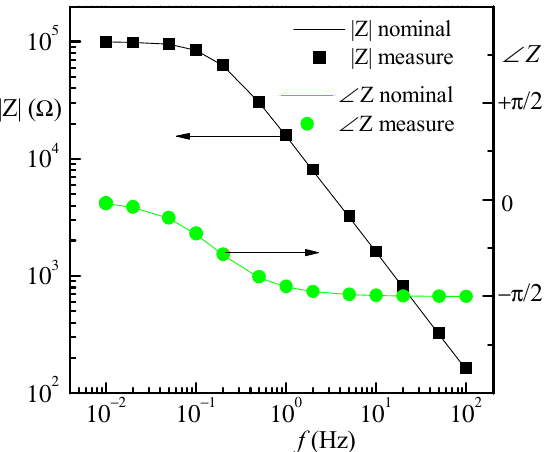
Figure 8. Result of test measurements on the impedance in Figure 6a. DC bias across the DUT was set to 0 and the AC amplitude of the test voltage was 10 mV at all frequencies. Quite good agreement is obtained between measurements (symbols) and the expected values (solid lines).